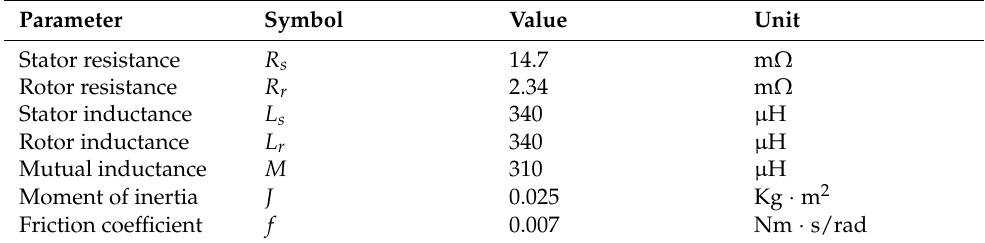
Table 2. Parameters of the electric